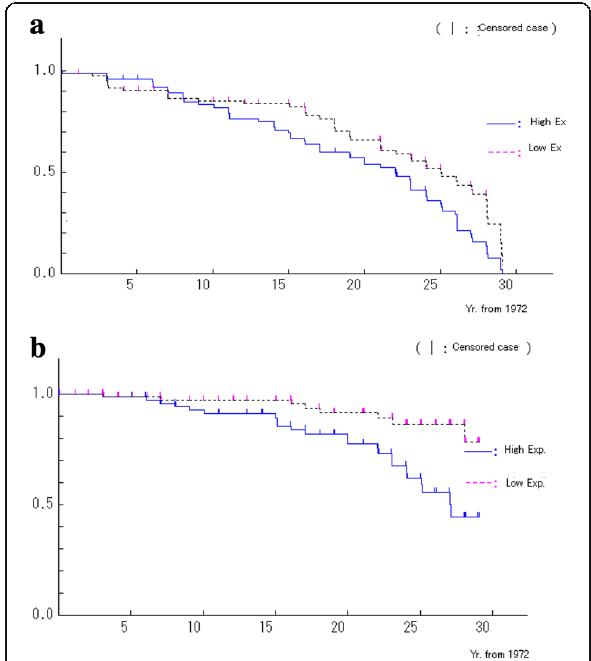
Fig. 3 a Survival curves of workers in high- and low-exposure workshops. Workshops for raw materials and textile were classified as high-exposure and those of asbestos cement and administration were classified as low-exposure. b Survival curves for lung cancer and mesothelioma for workers in high- and low-exposure